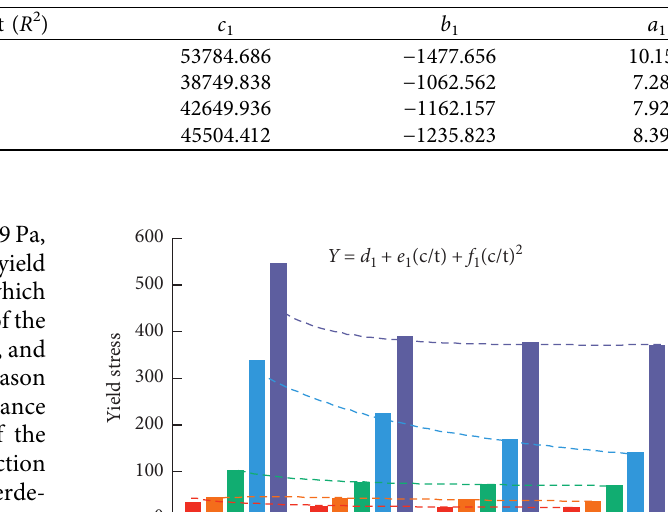
Table 7: Yield stress fitting results of CUTB samples under various